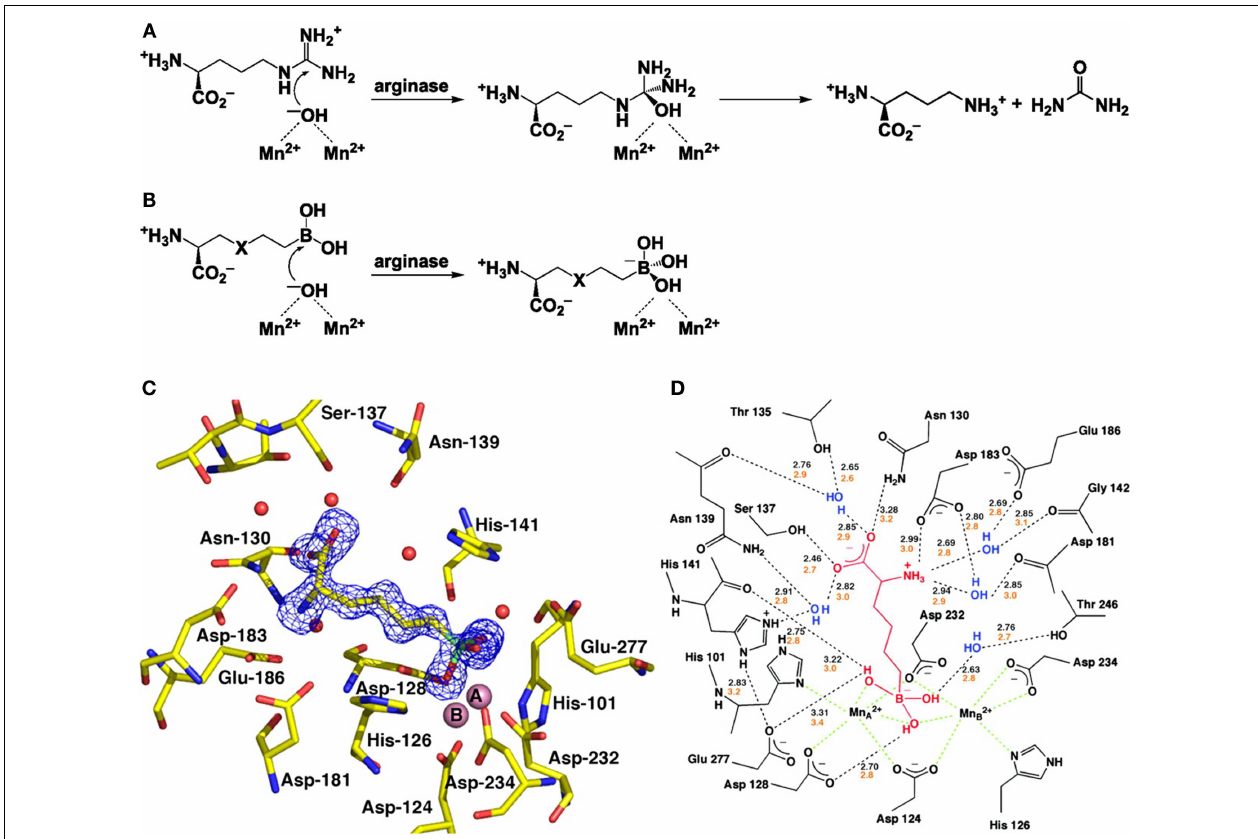
(BEC) (X representing S). (C) Electron density map of ABH bound to human arginase I. (D) A schematic showing the enzyme-inhibitor hydrogen bond (black dashed lines) and metal coordination interactions (green dashed lines). With kind permission from Santhanam et al.